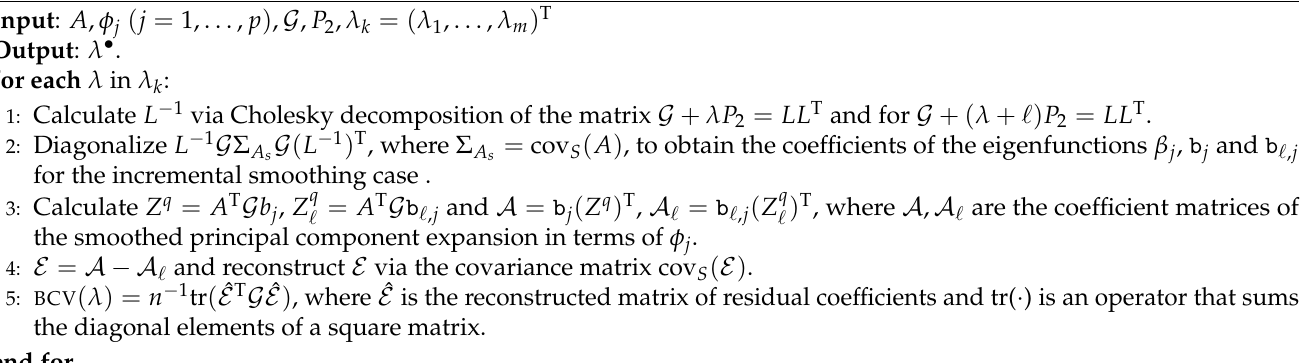
Algorithm 1. BASELINE CROSS -